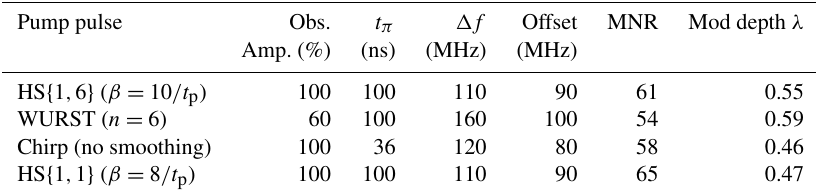
Table 5. The parameters of the observer and pump pulses resulting in the best MNR for each pulse type. All observer pulses are Gaussian pulses with pulse lengths of 74ns for 60% intensity and 56ns for 100% intensity. The observer frequency was 33.93GHz for all pulses. The MNR was evaluated up to